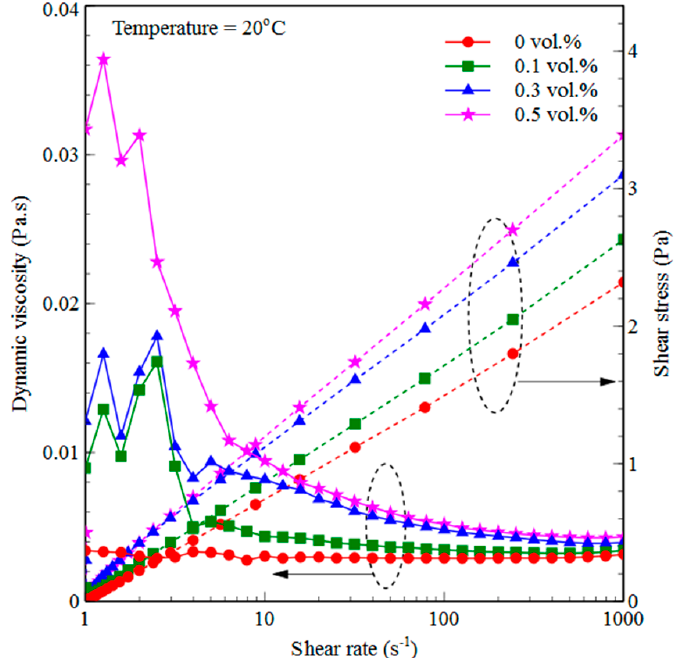
Figure 5. Effect of GnP loadings and shear rate on dynamic viscosity and shear stress of the PCM nanocomposites at 20 °C.